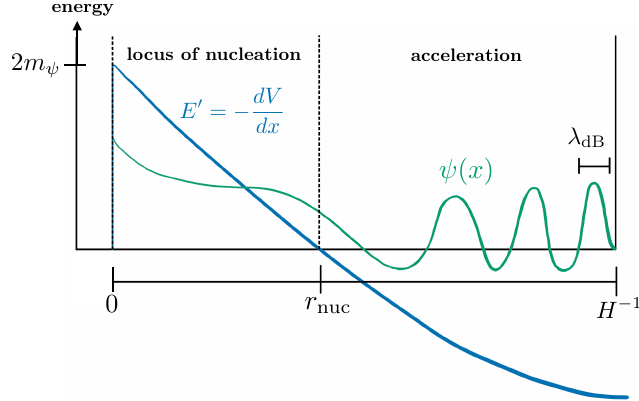
Figure 11. Particle-antiparticle pair nucleation (Schwinger process) in the semiclassical (WKB) approximation as an example of SFQED process in an expanding universe. The nucleation of the vacuum is analogous to the ionization of a bound state by a strong field. The presence of a cosmological scale H can be thought of as placing the system in a box of finite size H − 1 . The fermion tunnels through a distance r nuc , such that the work done over that distance is equal to the rest mass of the nucleated pairs (i.e. e d E 0 r nuc ’ 2 m ψ ), and is subsequently accelerated. As long as the size of the nucleation volume r nuc and the wavelength of the WKB wavefunction λ dB are much smaller than H − 1 and other intrinsic scales of variation of the external field, constant-field, flat spacetime results can be invoked, even if m ψ (cid:28) H